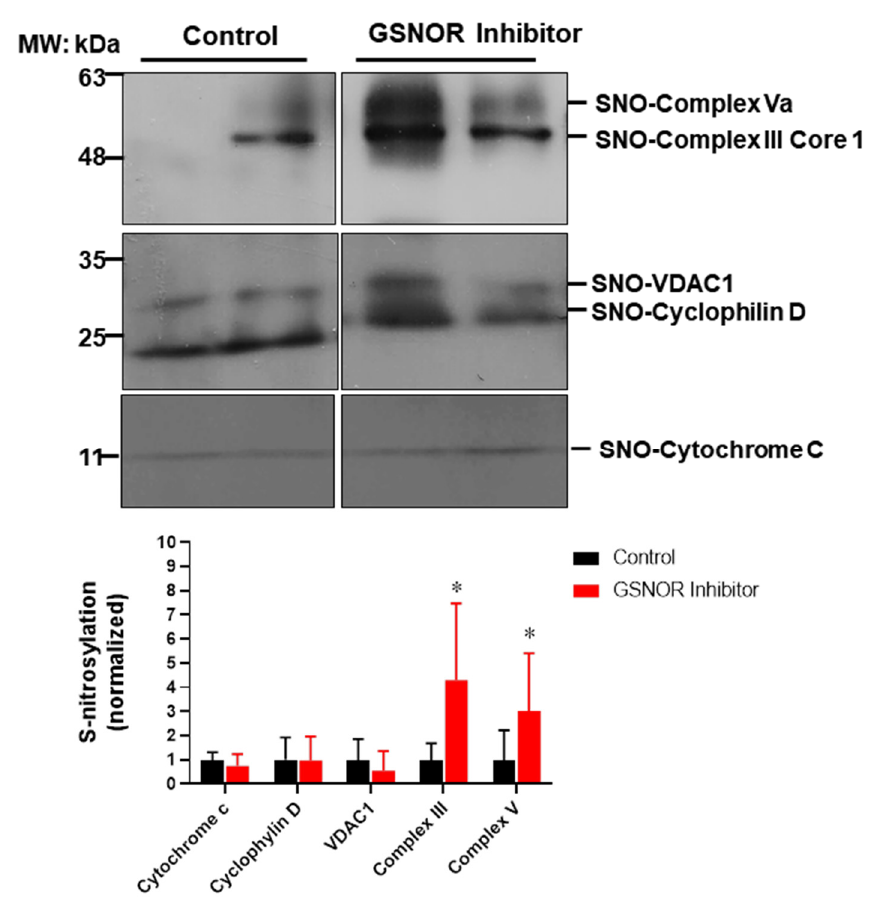
Figure 4. Impact of GSNOR inhibitor on cardiac mitochondrial S-nitrosylation. Analysis of mito- chondrial S-nitrosylated proteins from cardiac extracts of hearts submitted to ischemia reperfusion, treated with vehicle (DMSO) or with the GSNOR inhibitor C2, 1 µmol/L. The upper panels show representative Western blot images for S-nitrosylated proteins from hearts under control conditions or those treated with C2. The lower graph depicts the analysis of the levels of S-nitrosylation of the indicated mitochondrial proteins. Asterisk (*) indicates p < 0.05 vs. control, n = 5 in each group, except for cytochrome C ( n = 3).